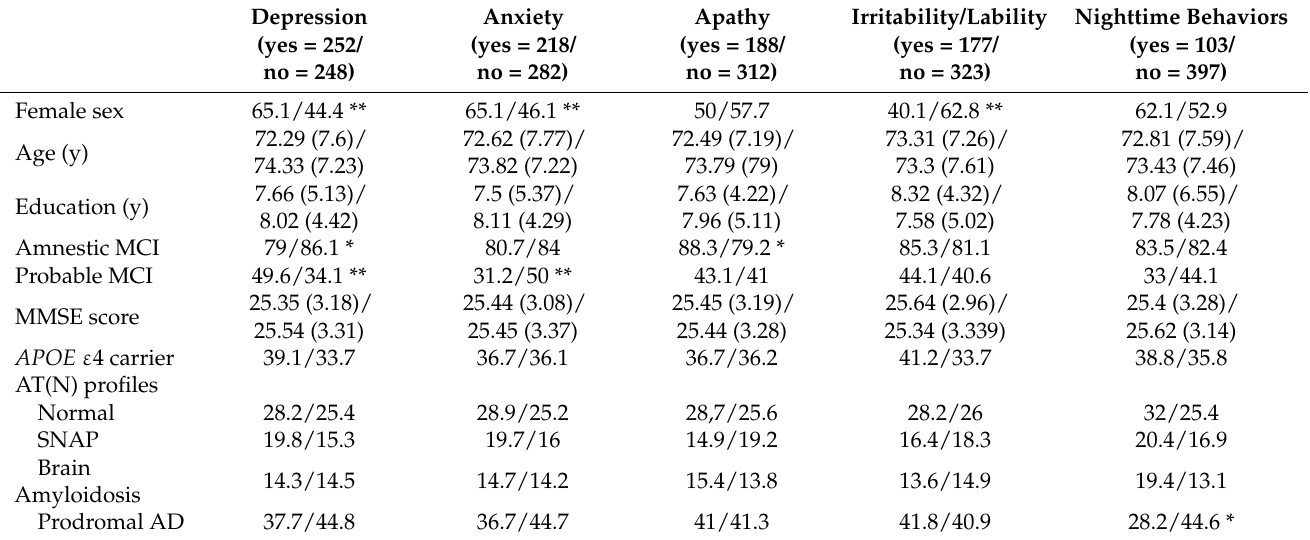
Table 3. NPS and their association with demographic and clinical